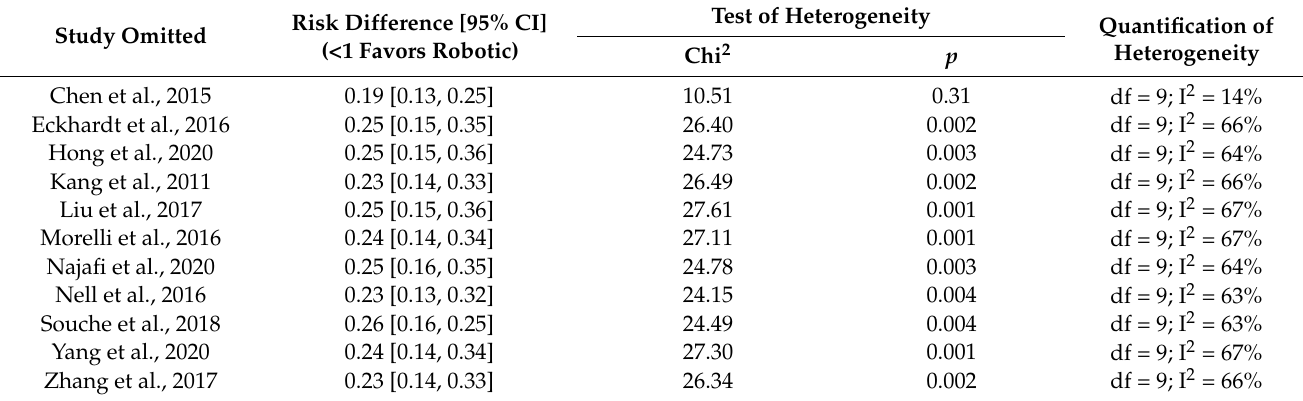
Figure 2. Spleen preservation rate forest plot. Table 2. Sensitivity analysis by sequential omission of each individual study. Meta-analysis estimates, given the named study is omitted. CI: confidence